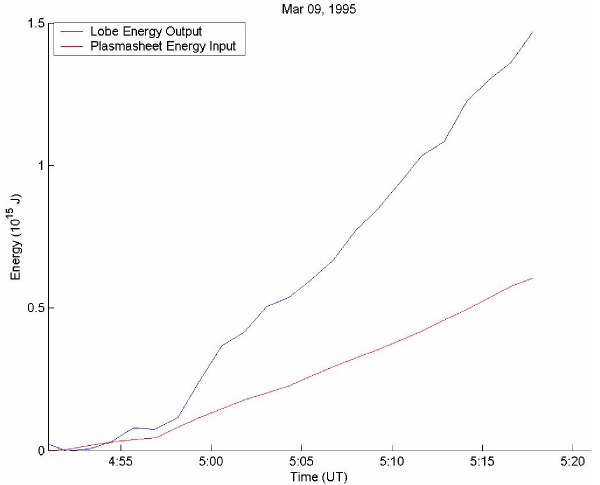
Fig. 4. The absolute amount of decrease in the lobes after the 9 March 1995 substorm onset and the absolute amount of increase of magnetic energy in the plasma sheet is shown. The ratio of the two is 42%.